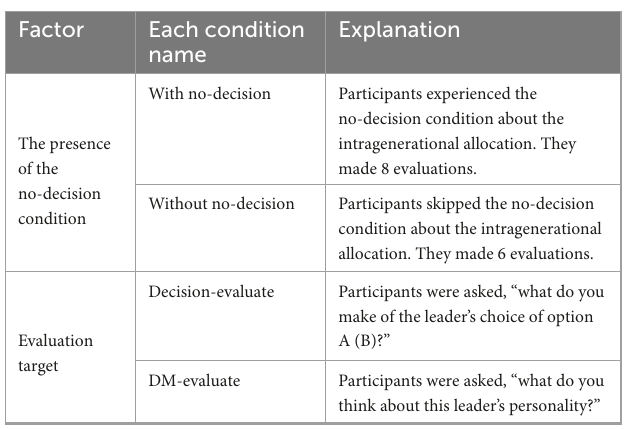
TABLE 3 The summary of the between-participants conditions.